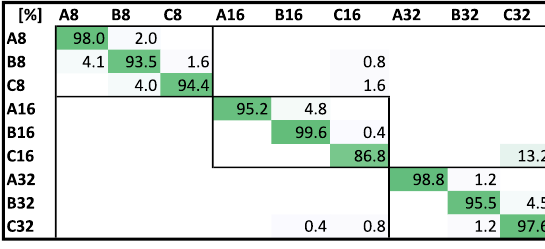
Figure 7. Confusion matrices obtained from different classifications. The values are to be read as amount of images (in [%]) of each reference class (rows) that are classified as the predicted class (columns). The colour coding denotes low values (light green) and high values (dark green). Empty entries correspond to values